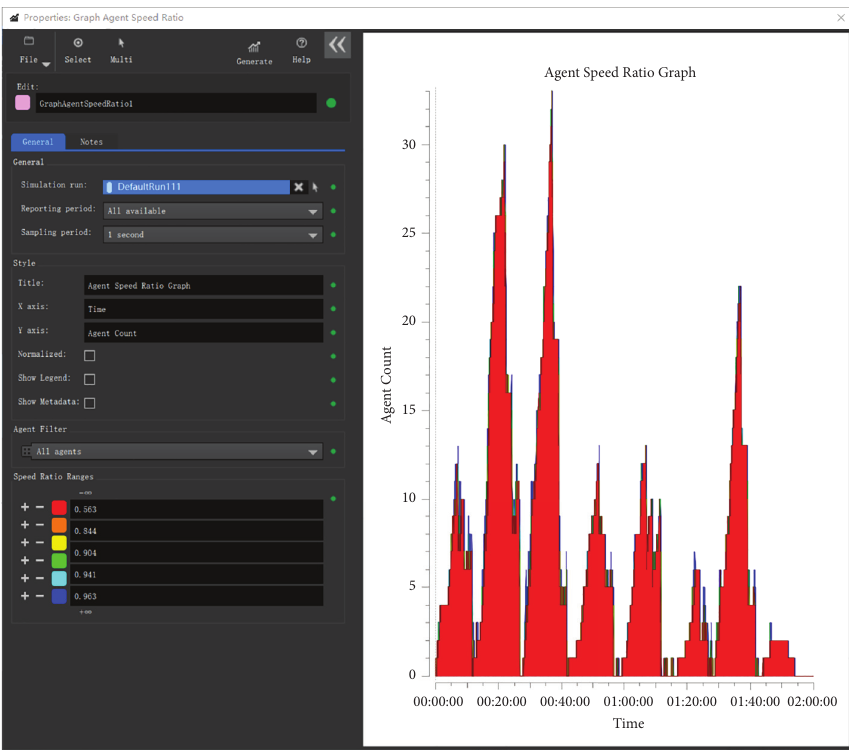
Figure 7: Massmotion simulation individual speed ratio chart.